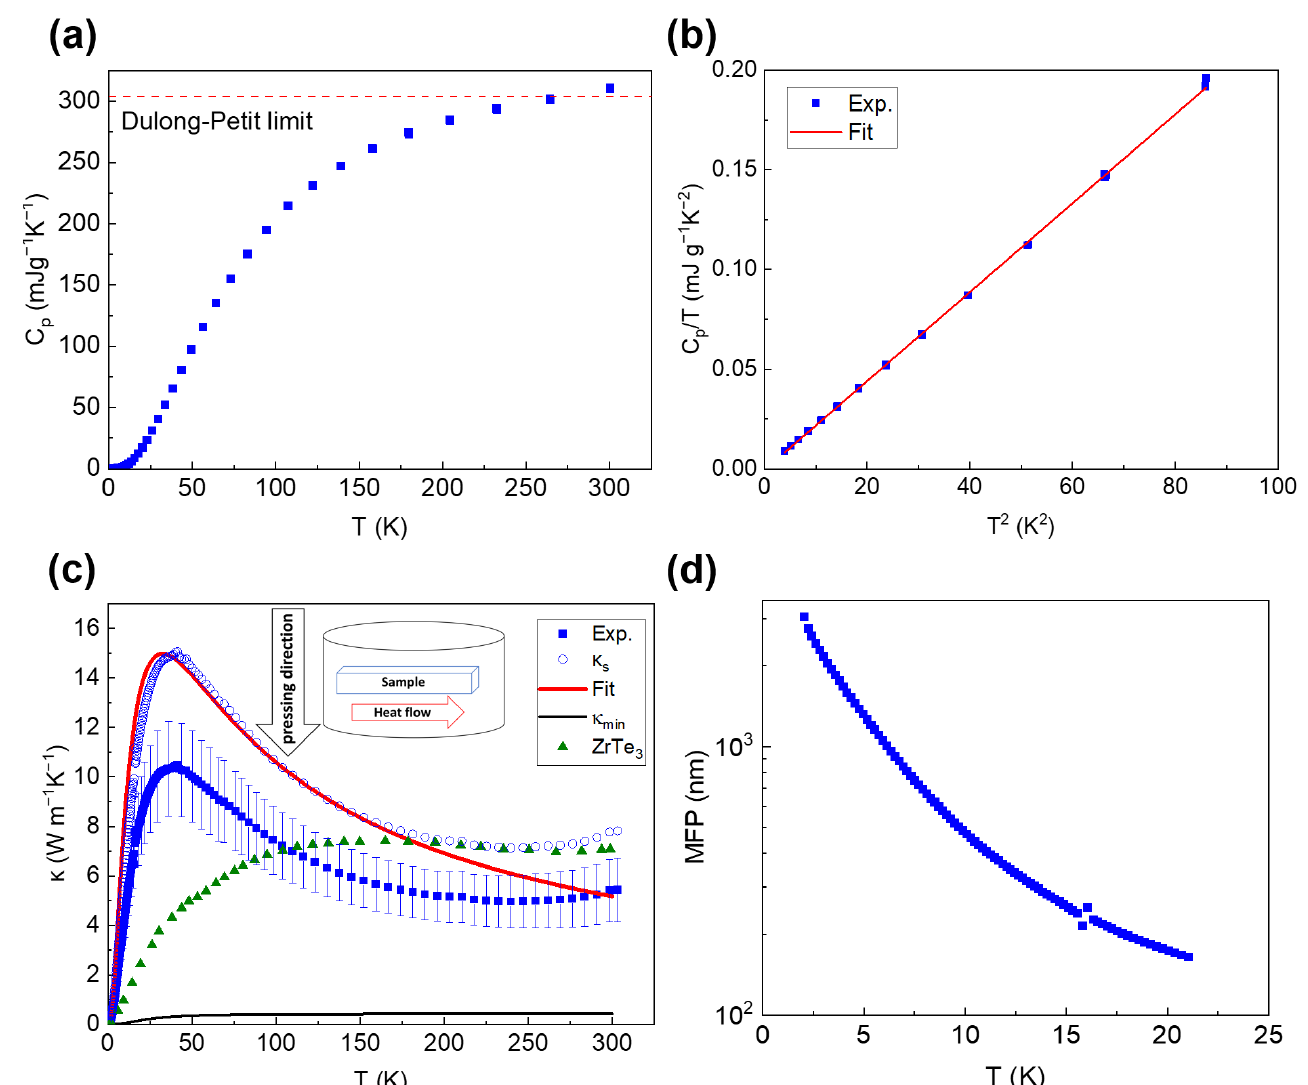
Figure 6. ( a ) Specific heat as a function of temperature for ZrSe 3 . The high-temperature limit was calculated using the Dulong–Petit law. ( b ) C p / T versus T 2 at low temperatures. ( c ) Thermal conductivity of ZrSe 3 as a function of temperature. The solid thermal conductivity was calculated by correcting the porosity effect. The experimental data for ZrTe 3 are included for comparison [40]. The solid thermal conductivity was fitted using the Debye model. The minimum thermal conductivity was calculated via the Cahill model [41]. The inset of ( c ) is a schematic illustration of the thermal conductivity measurement direction. Reprinted/adapted with permission from Ref. [40]. Copyright